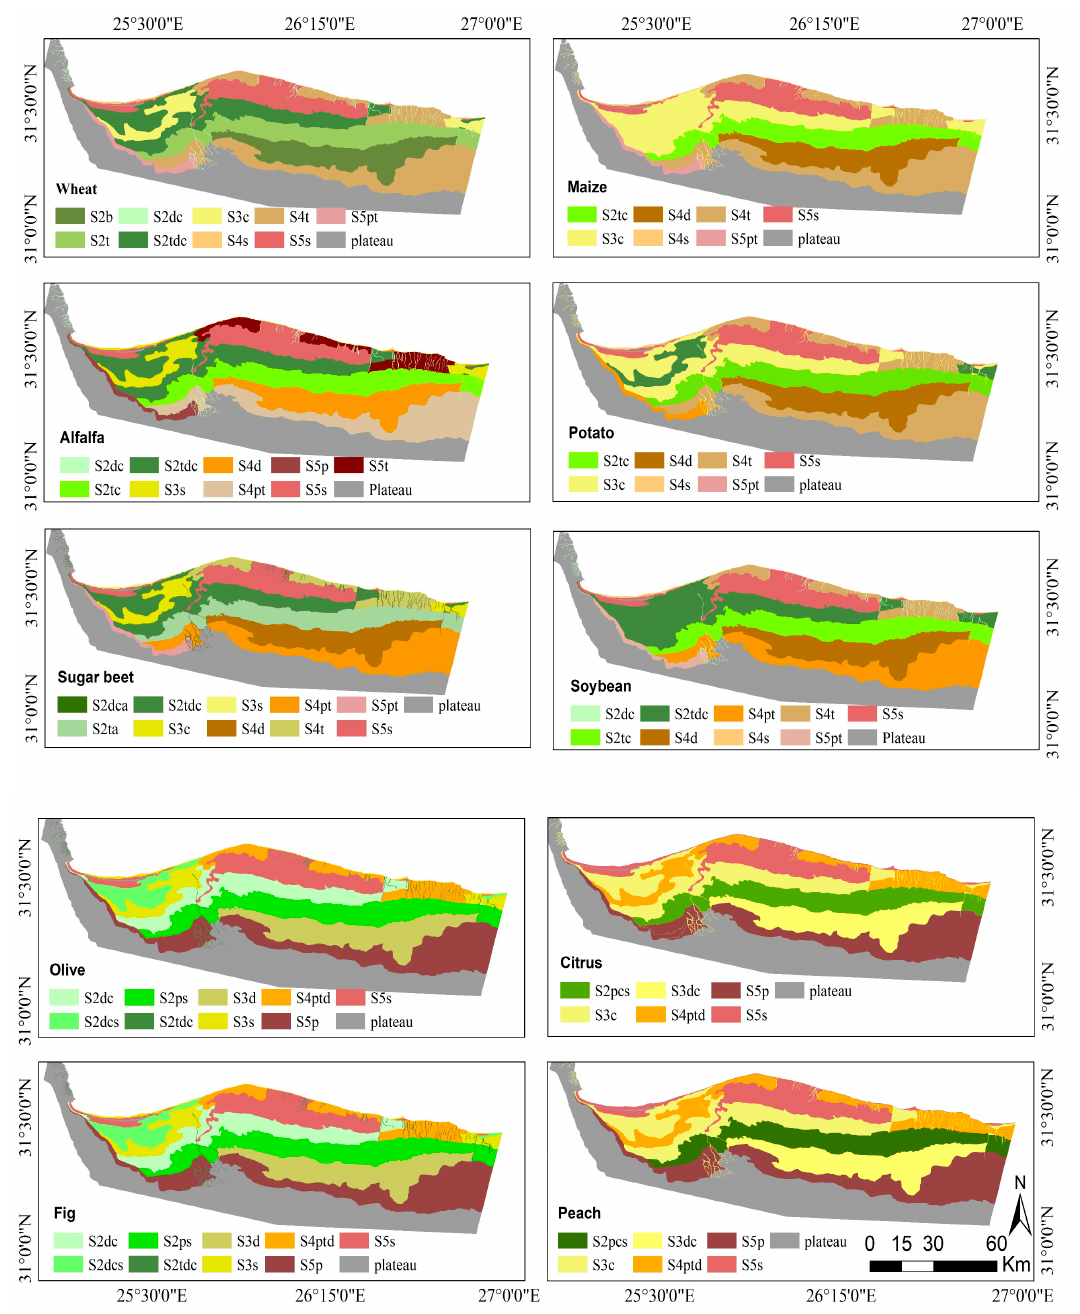
Figure 8. Crop suitability map for some field and horticultural crops. The main limiting factors; s, salinity; t, texture; a, sodium saturation; d, drainage; c, carbonate content; p, profile